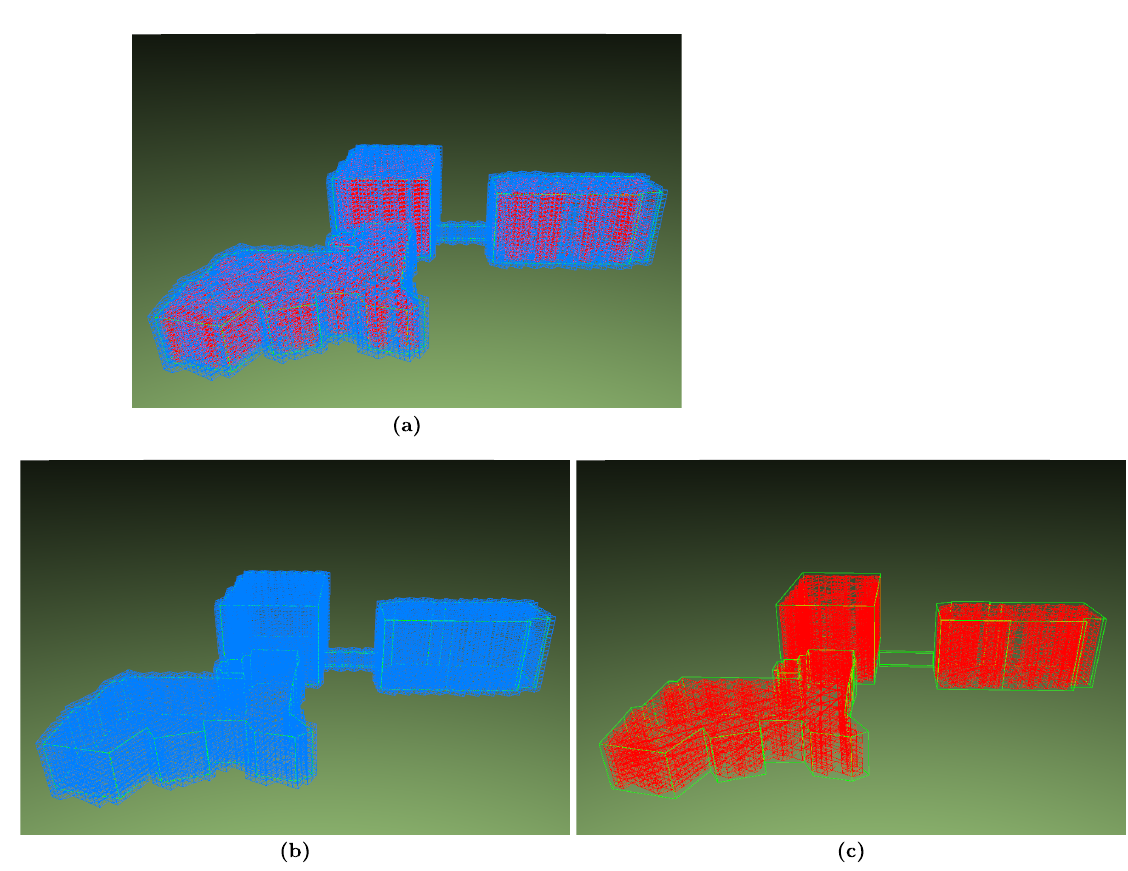
Figure 14. A collection of buildings from the University of Calgary rasterized in a 3D DGGS at resolution 21. In ( a ), both interior and boundary cells are shown, whereas ( b , c ) show only boundary and interior cells,